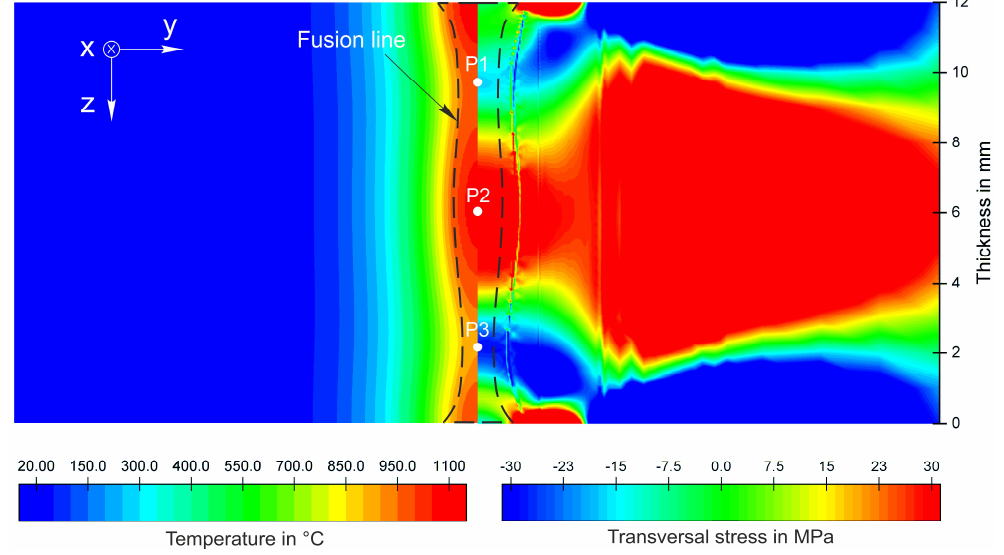
Figure 13. Transversal stress distribution and temperature distribution after solidification of the weld pool.